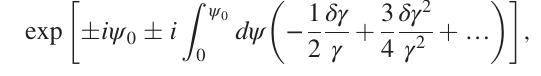
ffiffiffiffiffiffiffiffiffiffiffiffiffiffiffiffiffiffiffi p γ ð t 0 Þ þ δγ